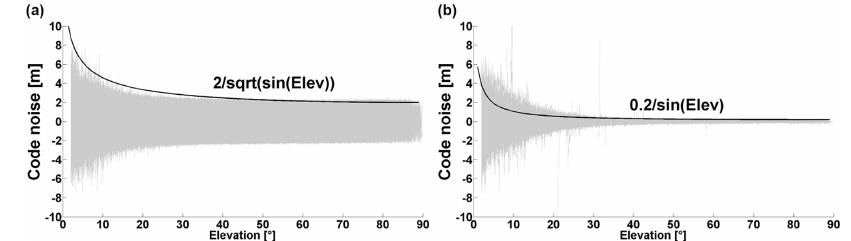
Figure 2. (a) P 1 code noise with respect to elevation for Swarm A on DoY 100 before fixing the RINEX converter issue and (b) DoY 104, 2016 after fixing the issue.